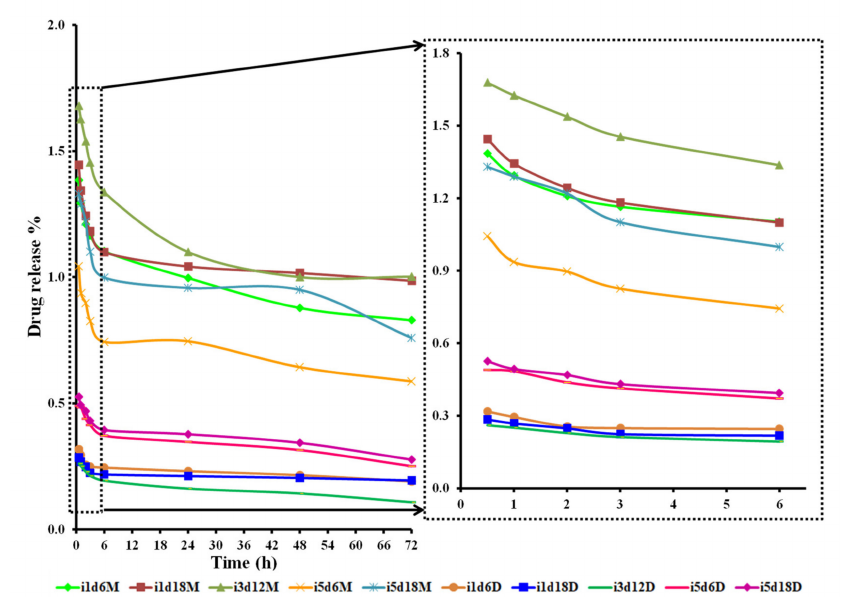
Figure 6. Drug release activity of BCd and BCm membranes over 72 h; i—inoculum, d—harvest day, M—moist membrane, D—dry membrane; the number following “i” stands for inoculum volume 1, 3, 5 mL and the number following “d” represents the harvest day 6, 12, 18